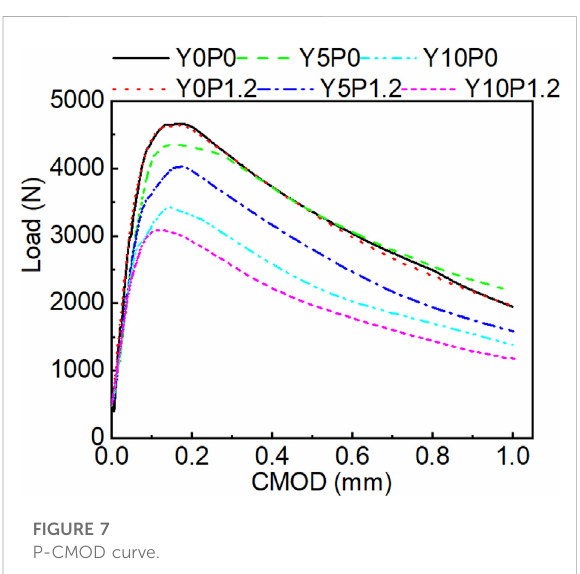
FIGURE 7 P-CMOD